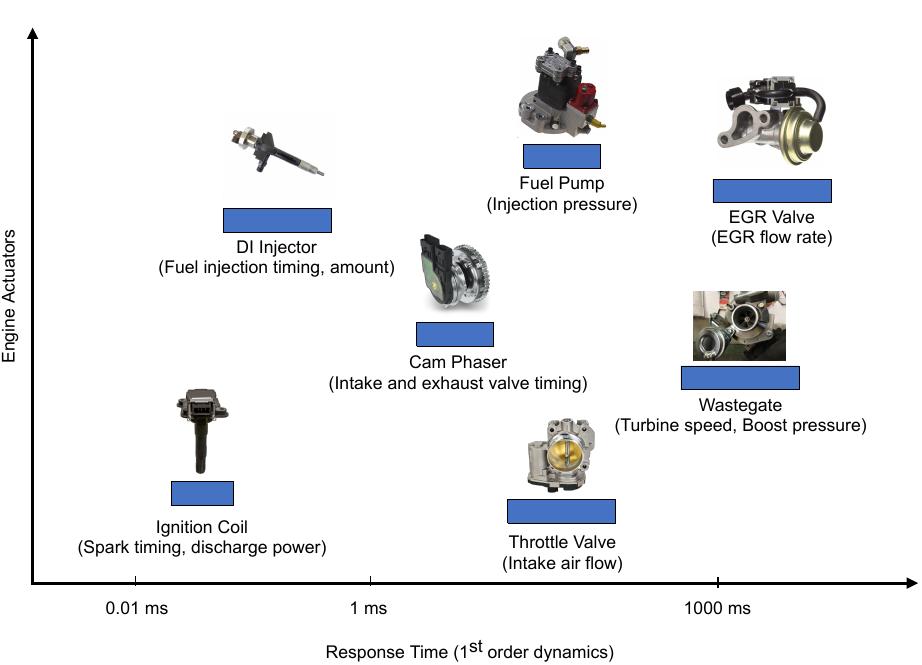
Figure 9. Typical engine actuators response times—assuming first order